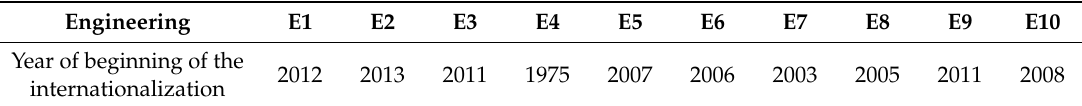
Figure 1. Percentages of activity areas of the companies interviewed. Table 5. Year of beginning of the international activity of the companies interviewed.